Question: Summarize what this figure shows in one sentence.
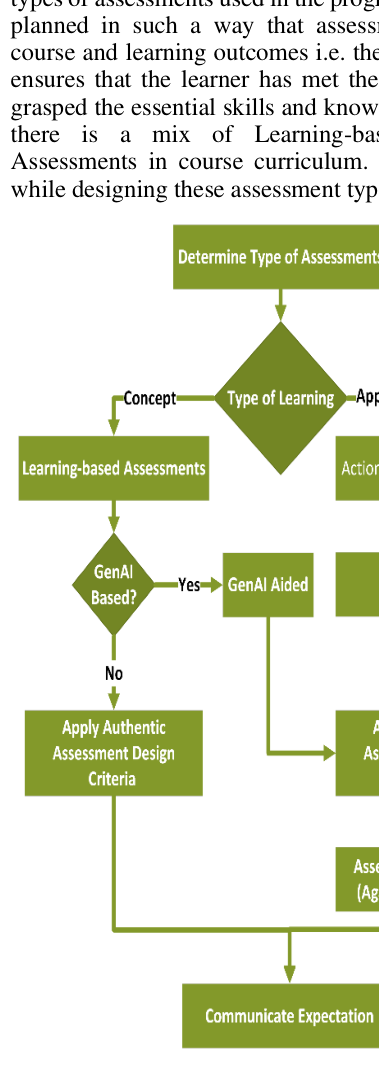
Answer: Proposed assessment design process.